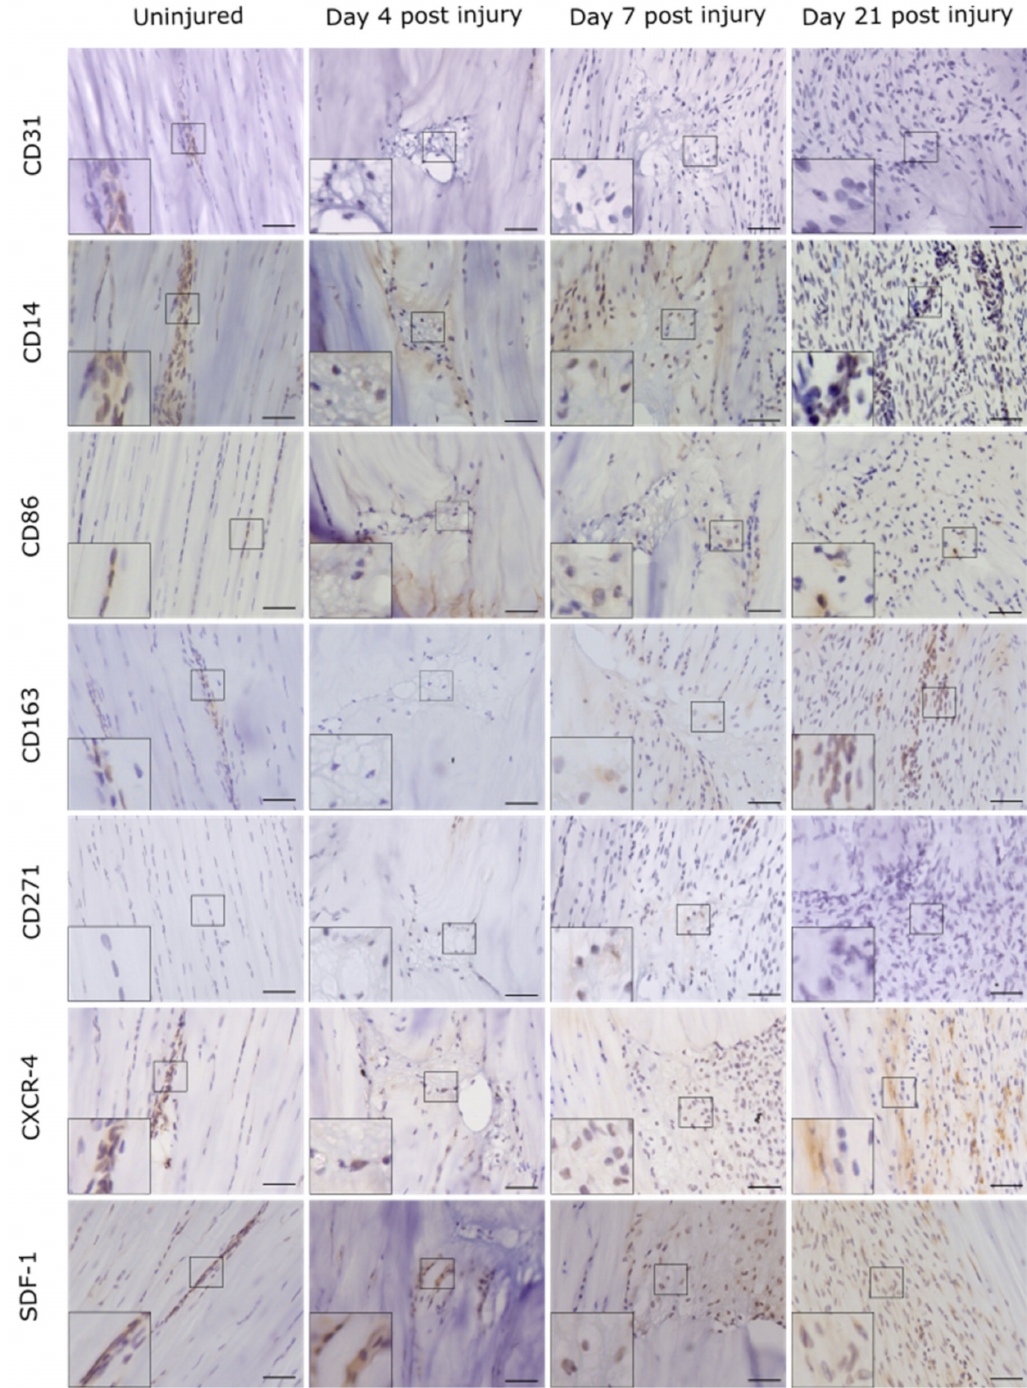
Figure 6. Injury response over time was assessed using immunohistochemistry for a panel of markers for progenitor cells, pericytes and macrophages. Images show the lesion site in injured tendons and the corresponding region in uninjured tendons. Positive staining is brown, with cell nuclei counterstained blue. Inset shows the region of interest magnified 2.5 times. Scale bar = 50 µ